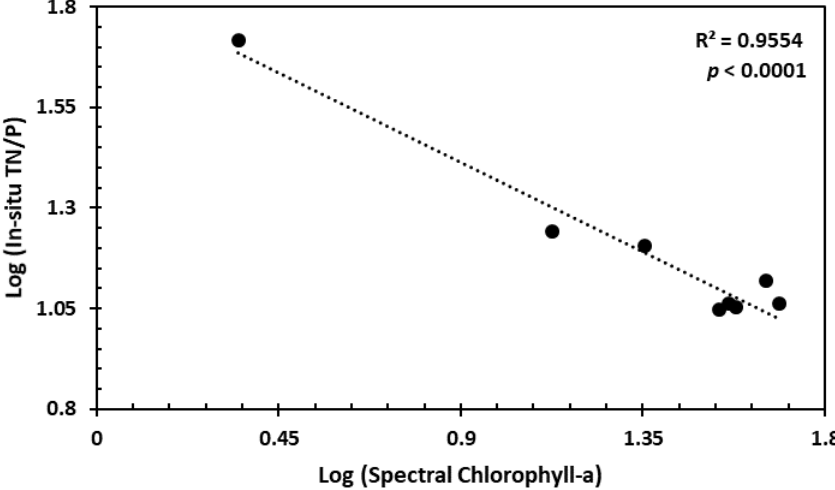
Figure 9. The relationship between log (spectral chlorophyll-a) and log (in-situ